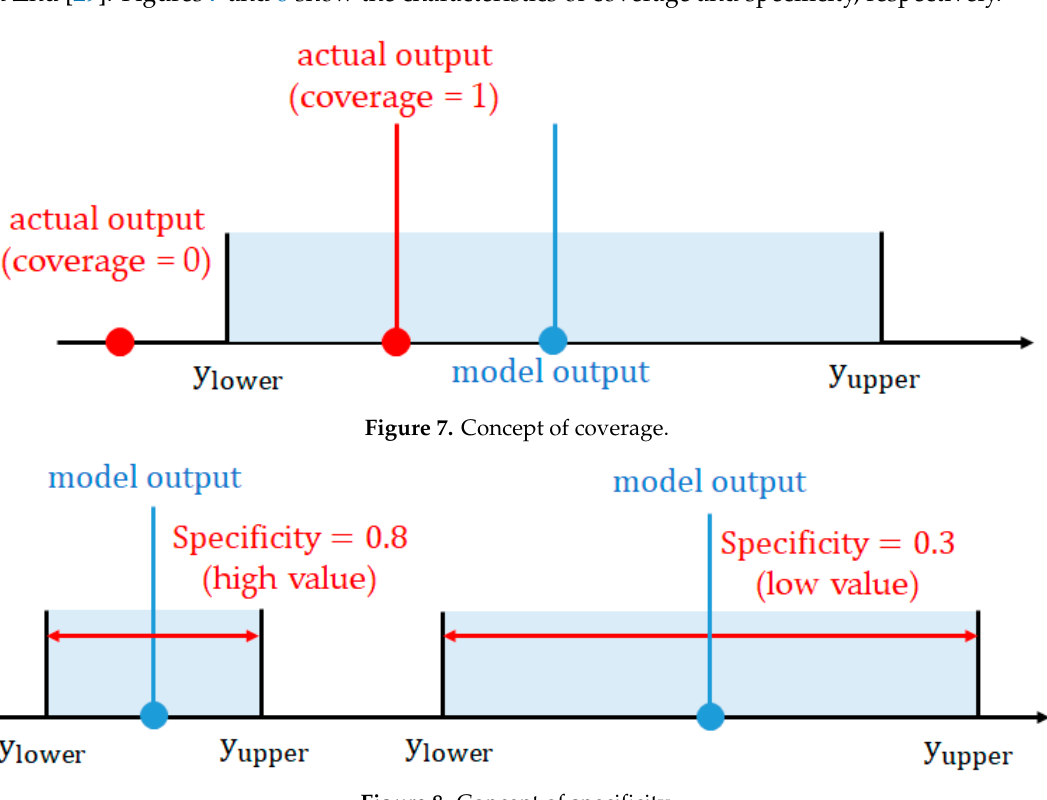
Figure 7. Concept of coverage.